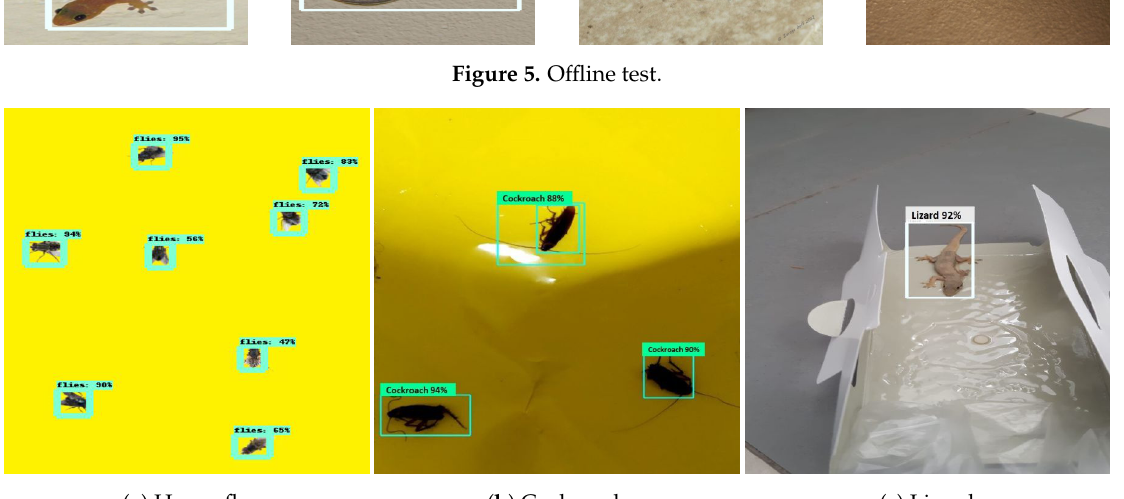
Figure 5. Offline test.